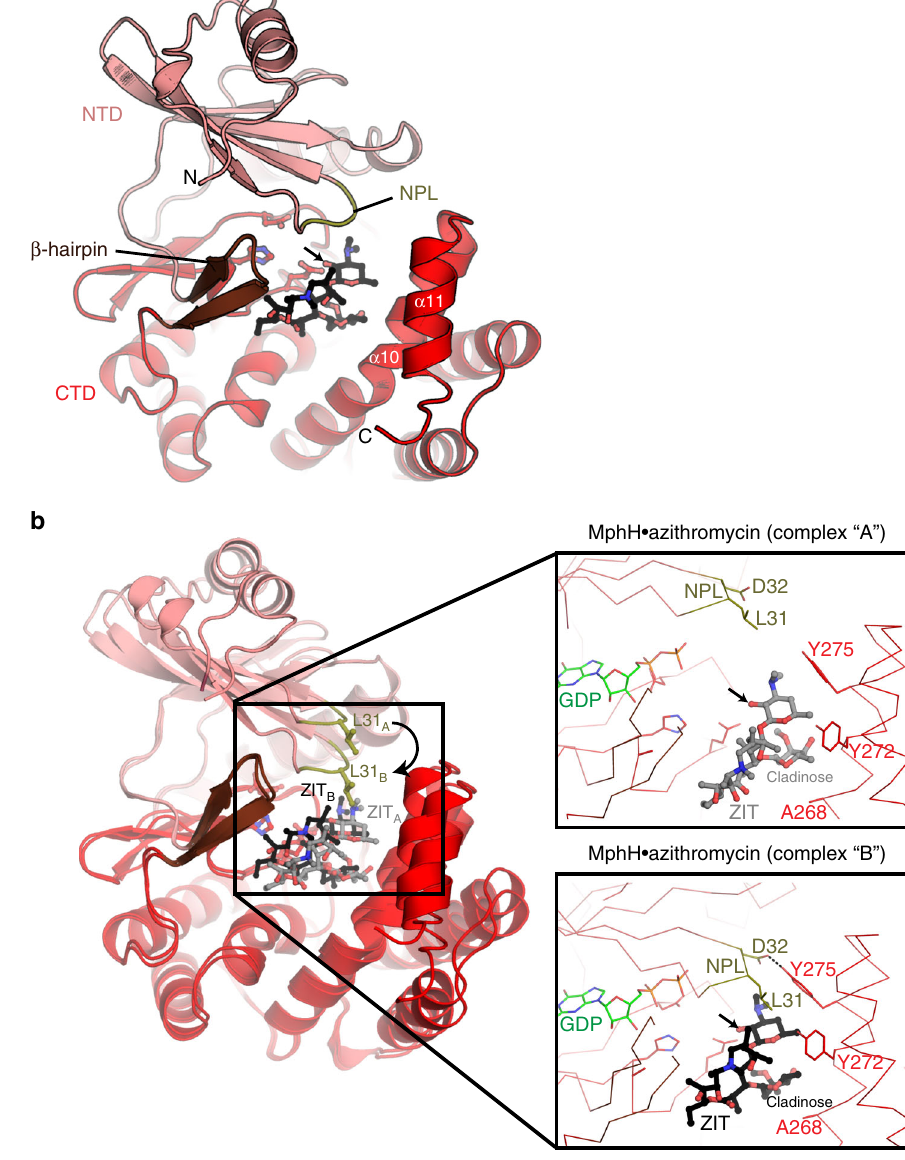
Fig. 4 Crystal structures of MphH. a The MphH • azithromycin (complex “ B ” of the two complexes in the asymmetric unit of this crystal) is shown in cartoon, with NTD, CTD, NPL, and β -hairpin regions colored differently. Azithromycin (ZIT) is shown in black ball-and-stick representation. α 10 and α 11 which make up one face of the macrolide-binding site are labeled. Catalytic residues Glu196, His201, and Asp214 are shown in ball-and-stick. Arrow indicates 2 ′ -OH site of phosphorylation on azithromycin. b Overlay of MphH • azithromycin complexes “ A ” and “ B ” , showing conformational differences in NPL (particularly Leu31), position of azithromycin and α 11. Inset shows zoom of macrolide-binding sites of each complex, showing key residues that contact the antibiotic compounds. Arrows indicate 2 ′ -OH site of phosphorylation on azithromycin. GDP is shown from crystal structure of MphH • GDP